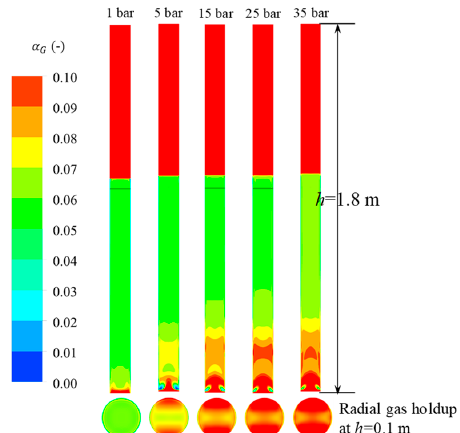
Figure 4. Gas holdup contours in air-water homogeneous bubble column at 1–35 bar (modified from Tran et al. (2019) Tran et al. (2019) [53]).